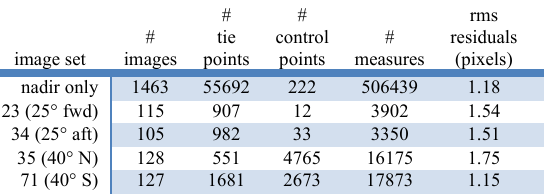
Table 2: Bundle adjustment statistics for AS15 MC. Results for 25° oblique orbits 23 (forward) and 34 (aft) are preliminary and were previously reported in Edmundson, et al.